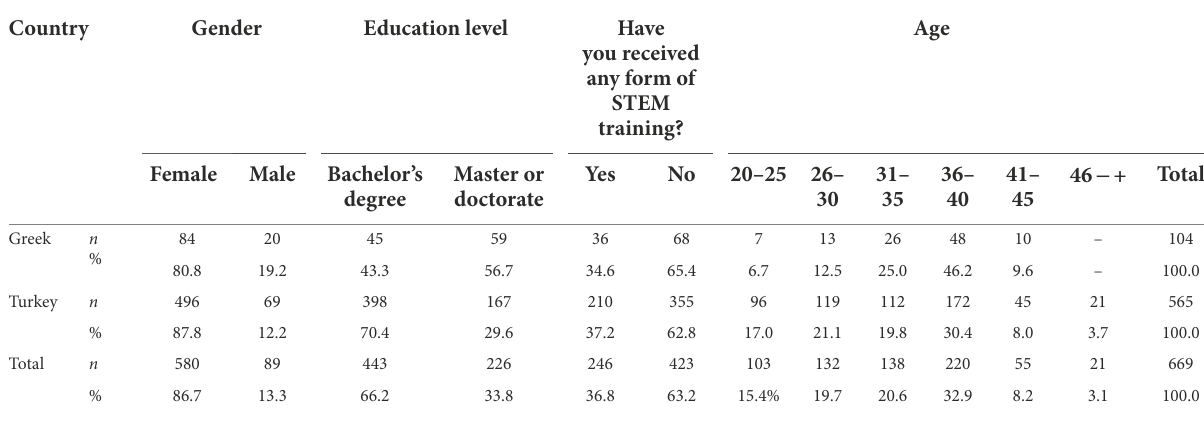
TABLE 2 Participants’ demographic